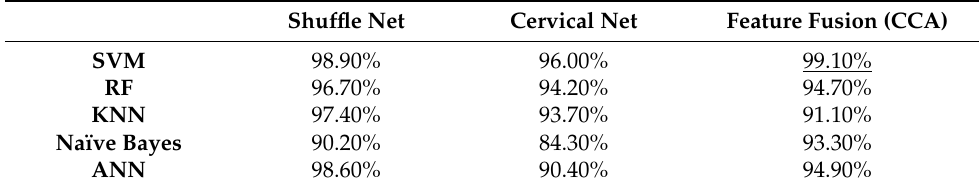
Table 3. The results obtained for all proposed methods.